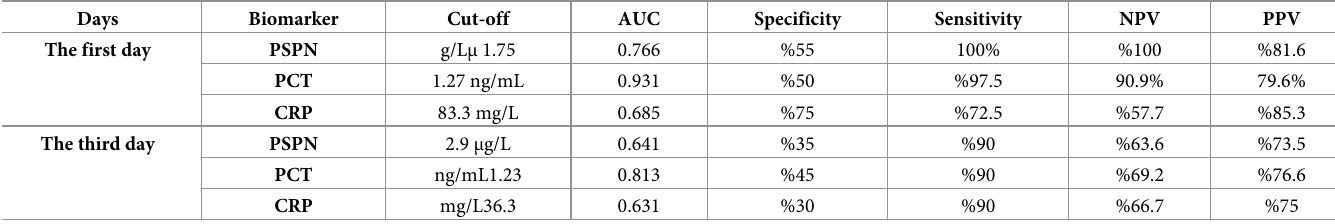
Table 3. Sensitivity, specificity, Negative Predictive Value (NPV), Positive Predictive Values (PPV) of cut- off values calculated over 2